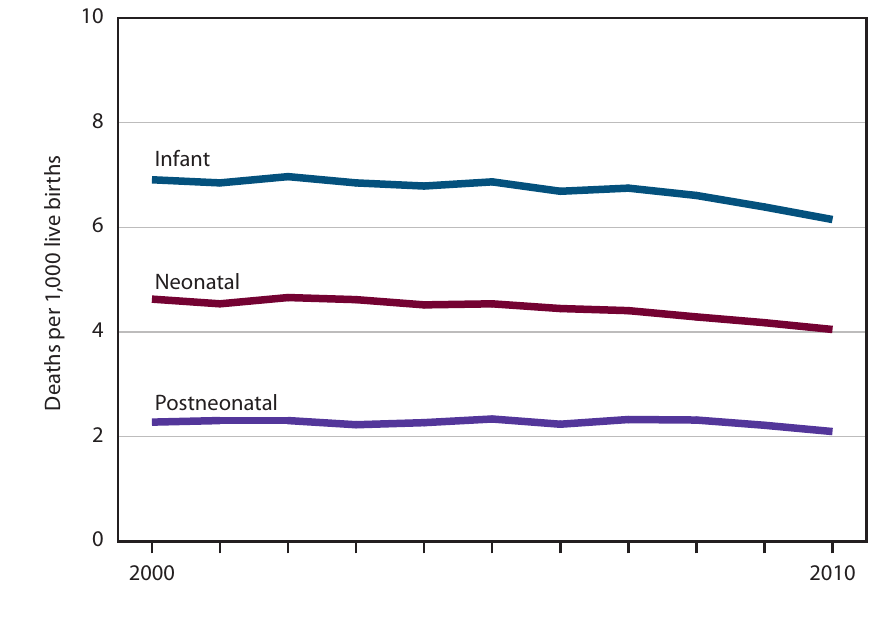
Figure 2. Infant, neonatal, and postneonatal mortality rates: United States, declined between 2000 and